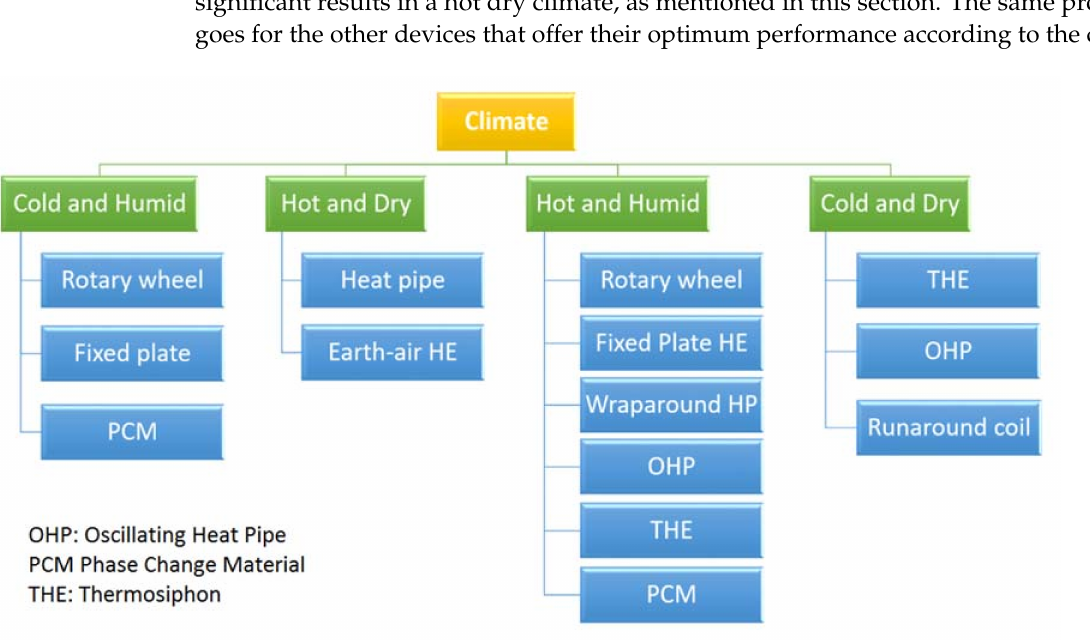
Figure 6. Heat recovery devices according to the